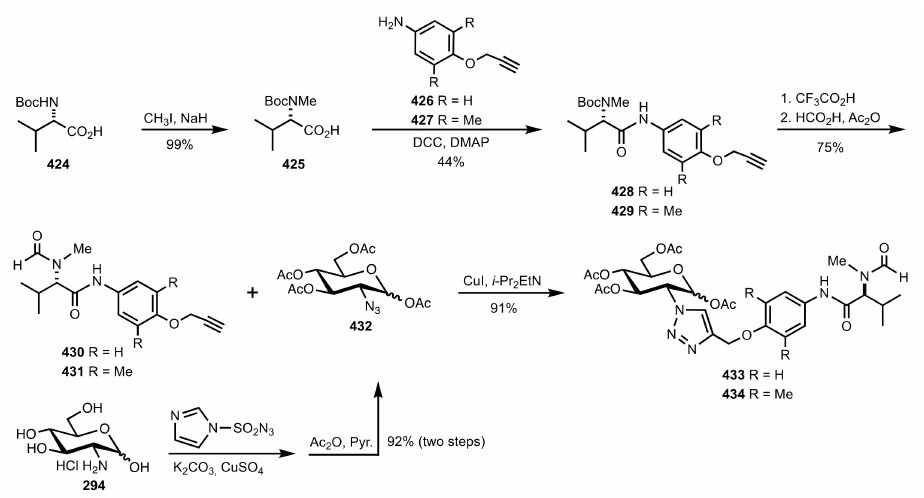
leads to chiral amines, which are useful building blocks for the synthesis of complex molecules. To this end, Qian and co-workers prepared [183] the two organocatalysts 433 and 434 in which a peracetylated glucose moiety was linked to the N -formyl- L -valine unit through a triazole ring (Scheme 115). The N -Boc- L -valine 424 was first N -methylated and then coupled under standard conditions to the aniline derivatives 426 and 427 bearing an O -propargyl group to afford the amides 428 and 429